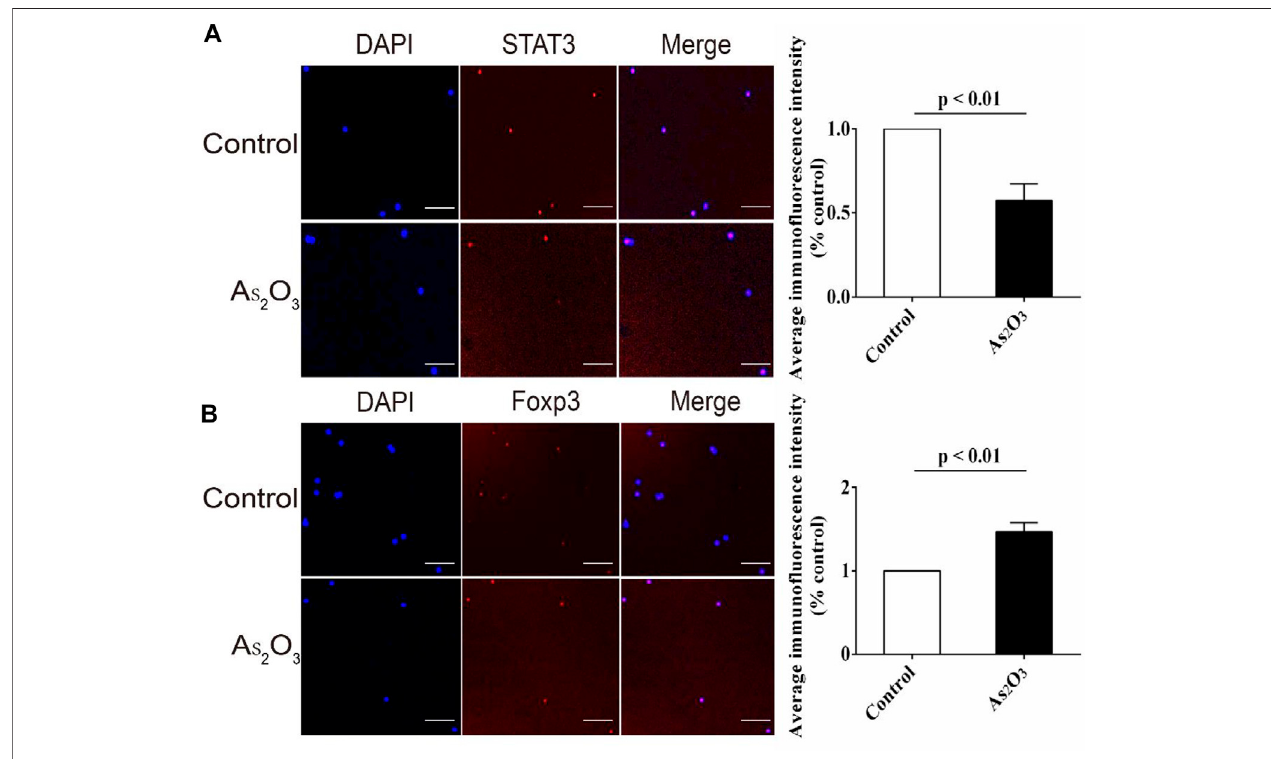
FIGURE 6 | As 2 O 3 increased gene expression of transcription factor Foxp3 for Treg cell while decreased STAT3 for Th17 cell from treatment-naïve RA patients. (A,B) PBMCs were extracted and cultured with anti-CD3/CD28 in presence or absence of As 2 O 3 for 24 h. Representative images of anti-STAT3 and anti-Foxp3 fl uorescence (red), nuclear DAPI (blue), and merged with the bright fi eld (Merge) in vehicle and As μ m As 2 O 3 treatment. Scale bars: 100 2 O 3 decreased the apparent STAT3 fl uorescence intensity while increased that of Foxp3 compared with vehicle group. STAT3 and Foxp3 levels were detected and quanti fi ed by the fl uorescence microscopy. The statistical analysis was performed using one-way ANOVA. Data are represented as the mean ± SEM in six independent experiments.